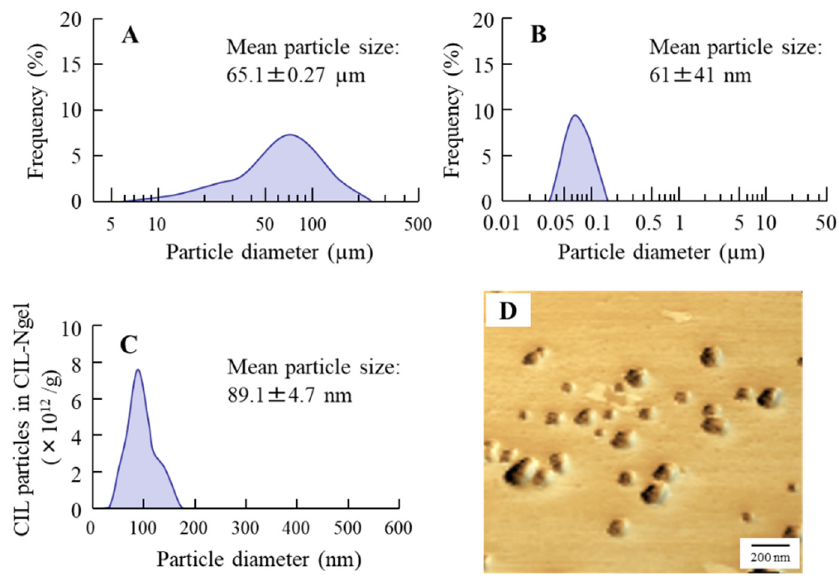
Figure 1. Particle-size frequencies and atomic force microscopy (AFM) image of cilostazol (CIL) in 0.5% CIL carbopol gel using solid nanoparticles (CIL-Ngel). ( A , B ), Particle-size frequencies of CIL in the gel containing CIL powder (CIL-Mgel) ( A ) and CIL-Ngel ( B ) using the SALD-7100. ( C ) Particle-size frequencies of CIL in the CIL-Ngel using the NanoSight LM10. ( D ) AFM image of CIL in the CIL-Ngel using the SPM-9700. The CIL particles in the CIL-Ngel were approximately 50–180 nm.